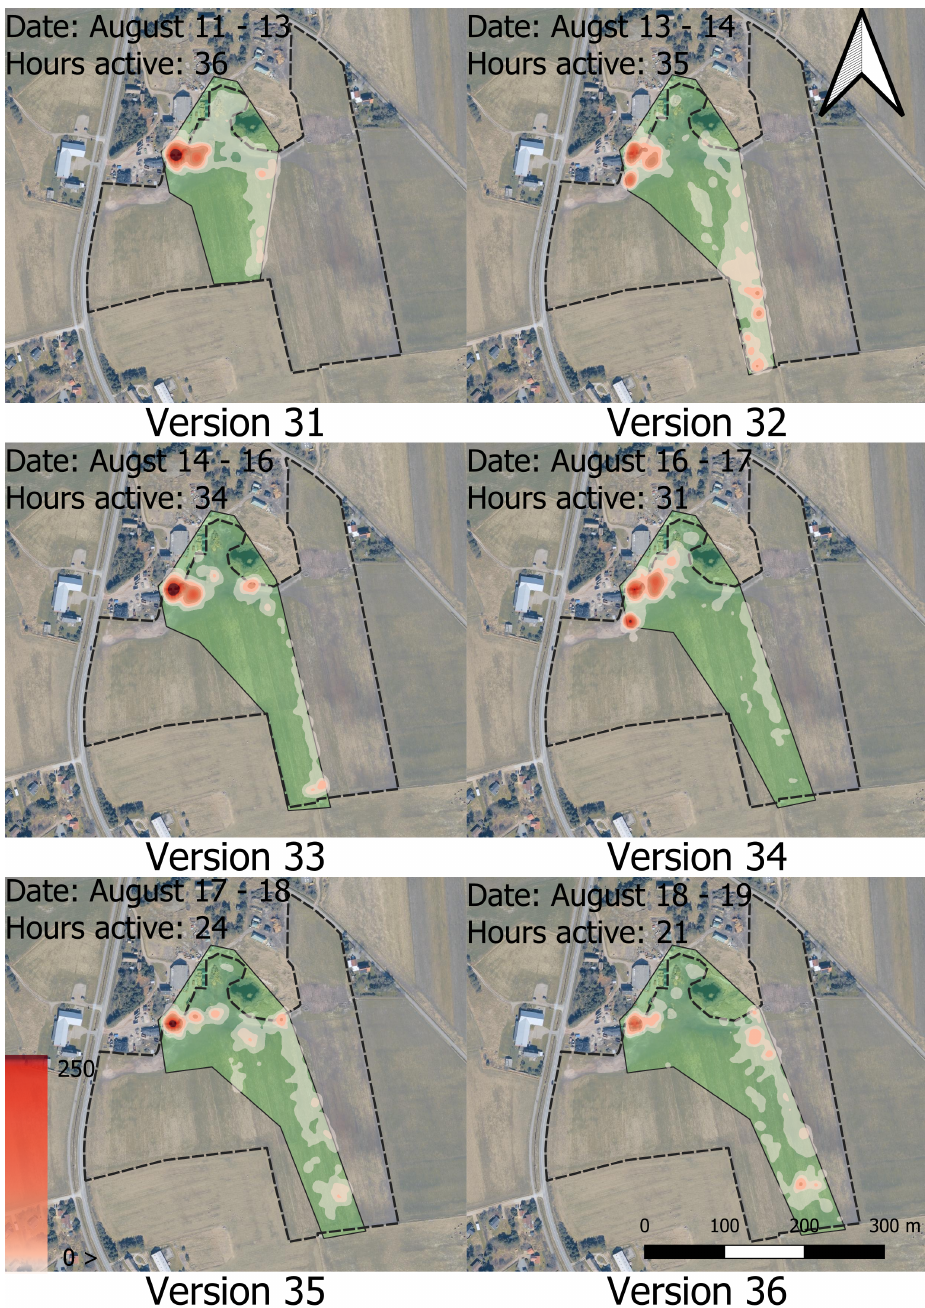
Figure A15. Heatmap series 6 visualising all Poll messages sent during the period from 11 August to 19 August. The green area shows the virtual enclosure area to which the bull calves were limited. The white to red colour indicates the number of Poll messages within a 10 m radius. The brightest colour represents the areas with the lowest density of Poll messages, while the darkest colour represents the areas with 250 or more Poll messages within the radius. The coordinates of the upper left corner of the map frame are 55°25 (cid:48) 23.131 (cid:48)(cid:48) E 8°23 (cid:48) 53.531 (cid:48)(cid:48) N. Contains data from the Agency for Data Supply and Infrastructure, Forårsbilleder Ortofoto-GeoDanmark, December